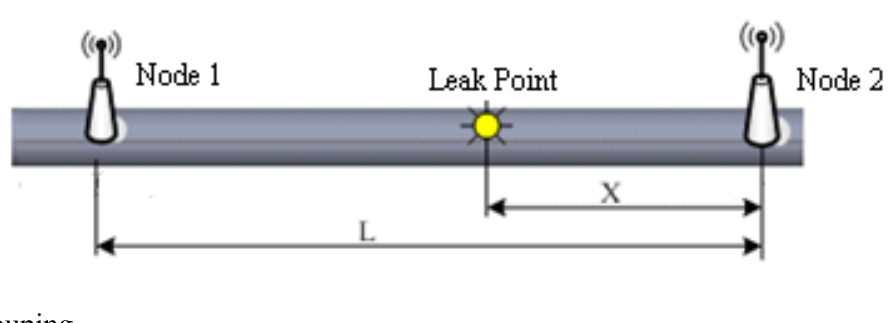
Figure 4. Principle of TDOA localization.